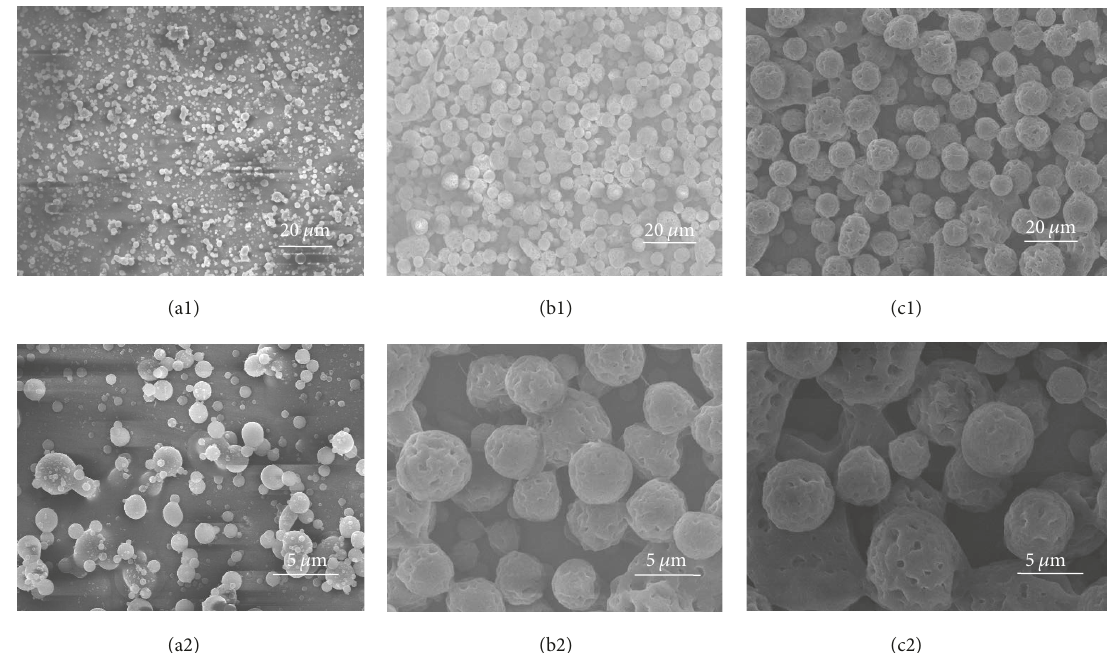
Figure 3: SEM observation of PLGA-CS MPs in different concentration of chitosan: PLGA-CS1 (a1, a2), PLGA-CS2 (b1, b2), and PLGA-CS3 (c1, c2).